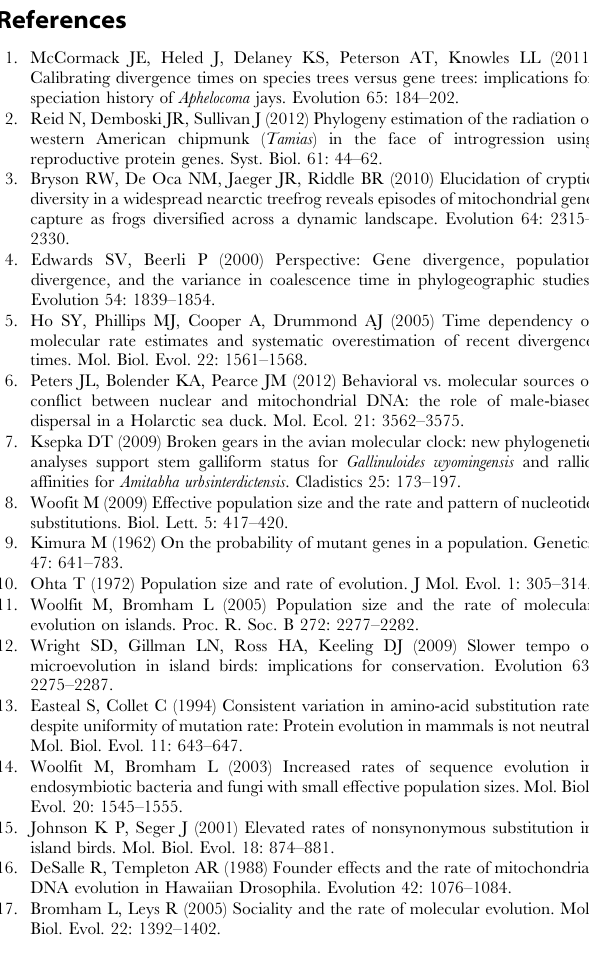
Figure S2 Cardinalis cardinalis mean branch lengths. Branch lengths were extracted from gene trees constructed using MrBayes. The branch length was the distance from each lineage to a common outgroup, Cardinalis sinuatus . Mean branch lengths were generated by averaging across all the individuals within a lineage. Table S1 Molecular clock likelihood ratio tests. Shown are locus name, sequence model, and likelihood scores for clock constrained and unconstrained for each gene tree. Gene trees that are inconsistent with the molecular clock are shown in bold. Table S2 Speciation time estimated from mtDNA and multilocus data. Table S3 Substitution rates and branch lengths ex- tracted from the mtDNA gene